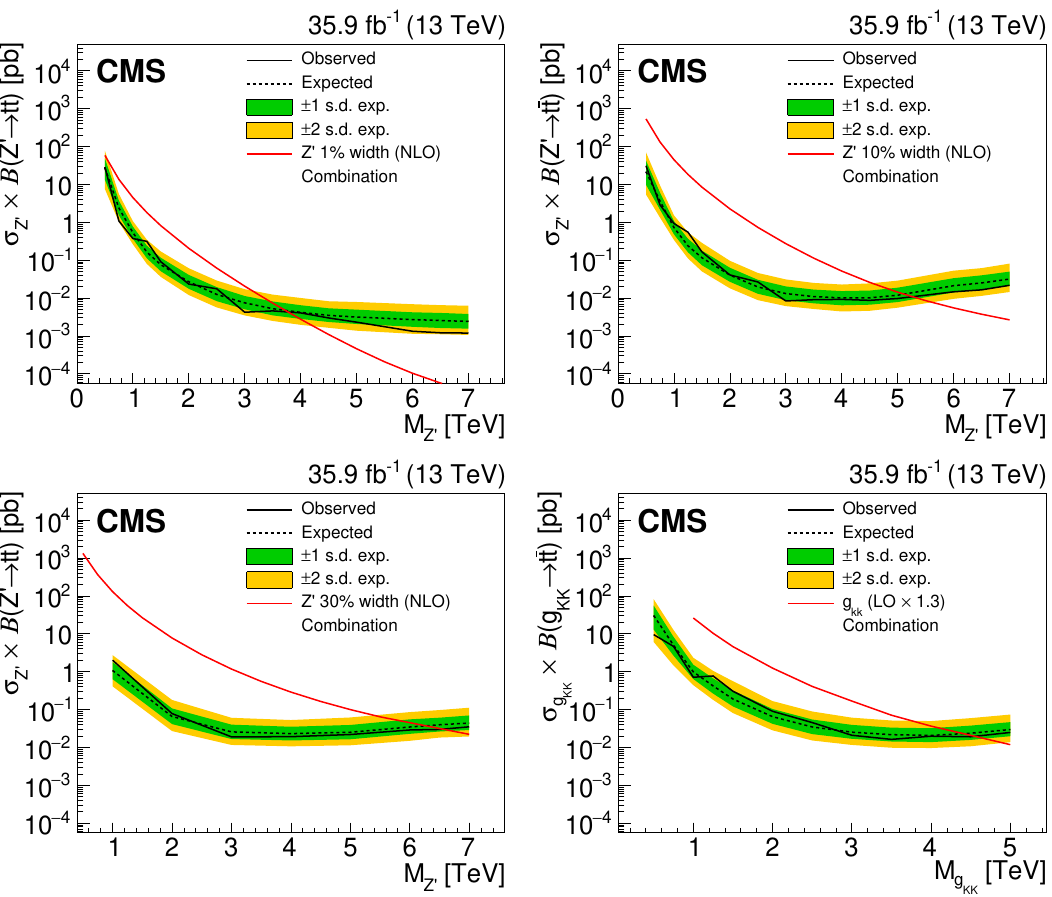
Figure 13 . Observed and expected limits at 95% CL for each of the four signal hypotheses considered in this